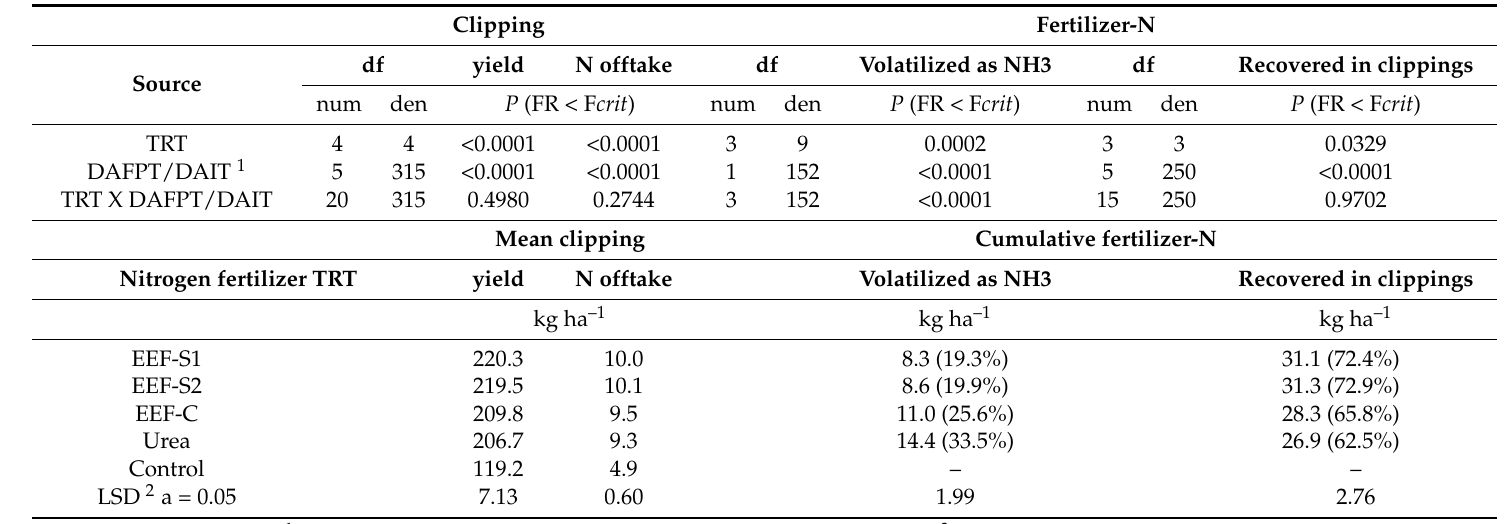
Table 2. Analysis of variance by fixed effect and dependent variable. Mean separation of clipping yield and N offtake, and cumulative fertilizer-N volatilized as NH 3 or recovered in clippings, by fertilizers. EEF-S1, stabilized urea (UFLEXX), EEF-S2, stabilized urea (UMAXX), EEF-C, coated-urea/urea blend